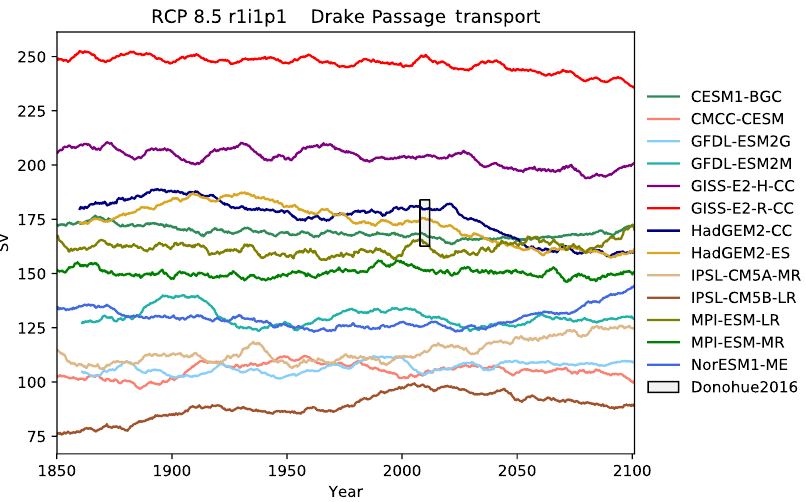
Figure 13. The Drake Passage Current. Each model is shown as a full line, and the historical measurement is shown as a grey area. The model data are a 5-year moving